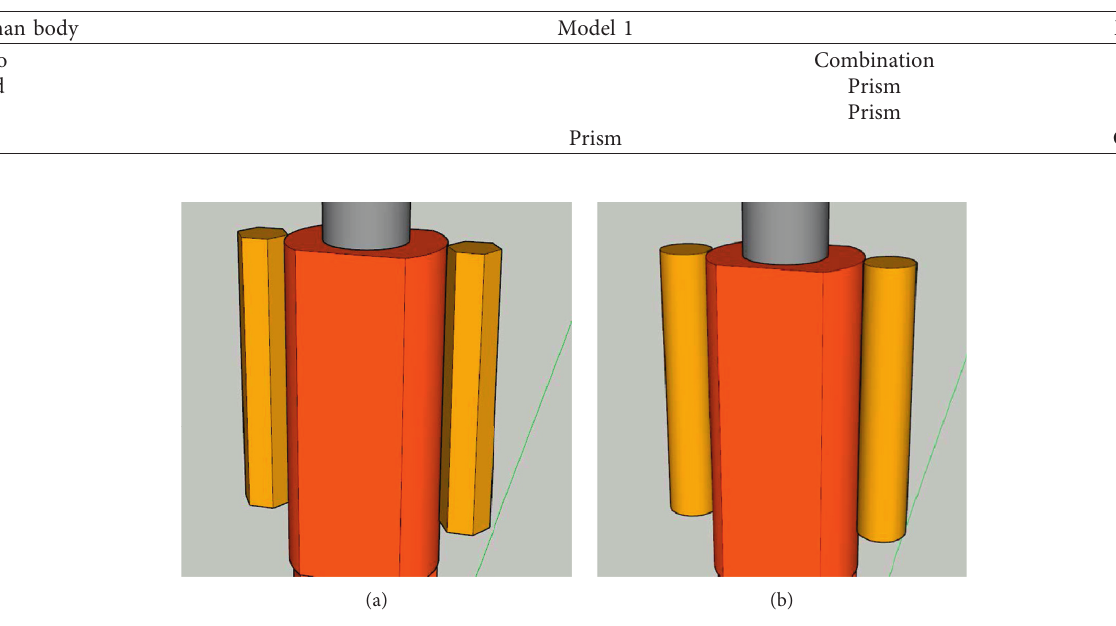
Figure 11: Two optional arm shapes. (a) Prism. (b) Cylinder.